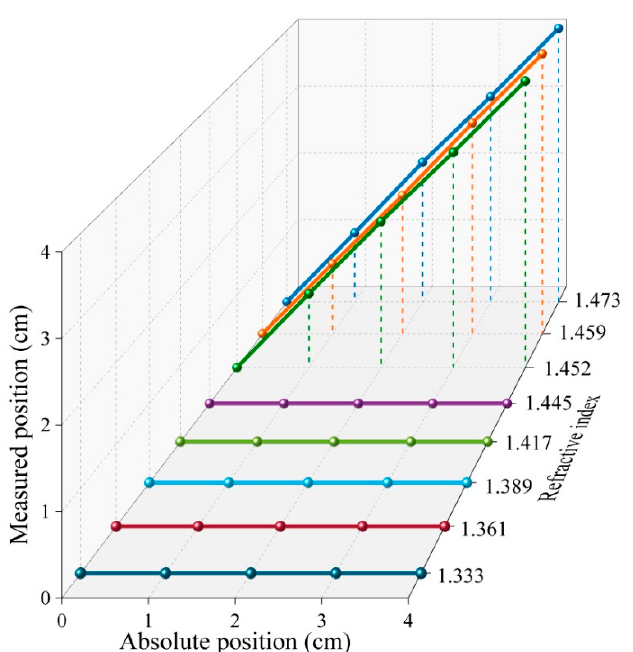
Figure 7. The liquid-level sensor under different refractive indexes from 1.333 to